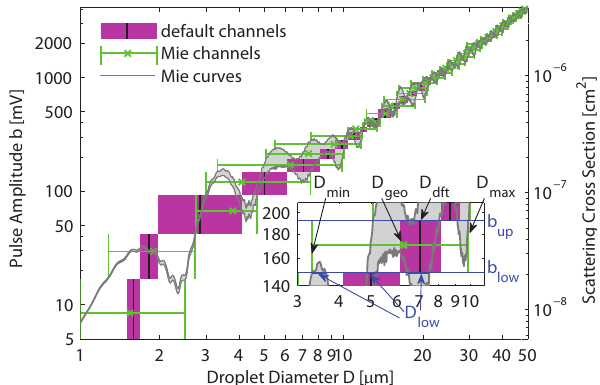
Fig. 3. Mie curves for a laser wavelength of λ =658nm as well as the default channels from the manufacturer (pink) and the Mie chan- nels (green). The inset shows for channel 5 how the minimum di- ameter D min and maximum diameter D max are deduced from the intersections of the Mie curves with b low ( D low ) and b up ( D up ). Additionally, the geometric mean diameter D geo and the diameter of the default channels are depicted ( D dft